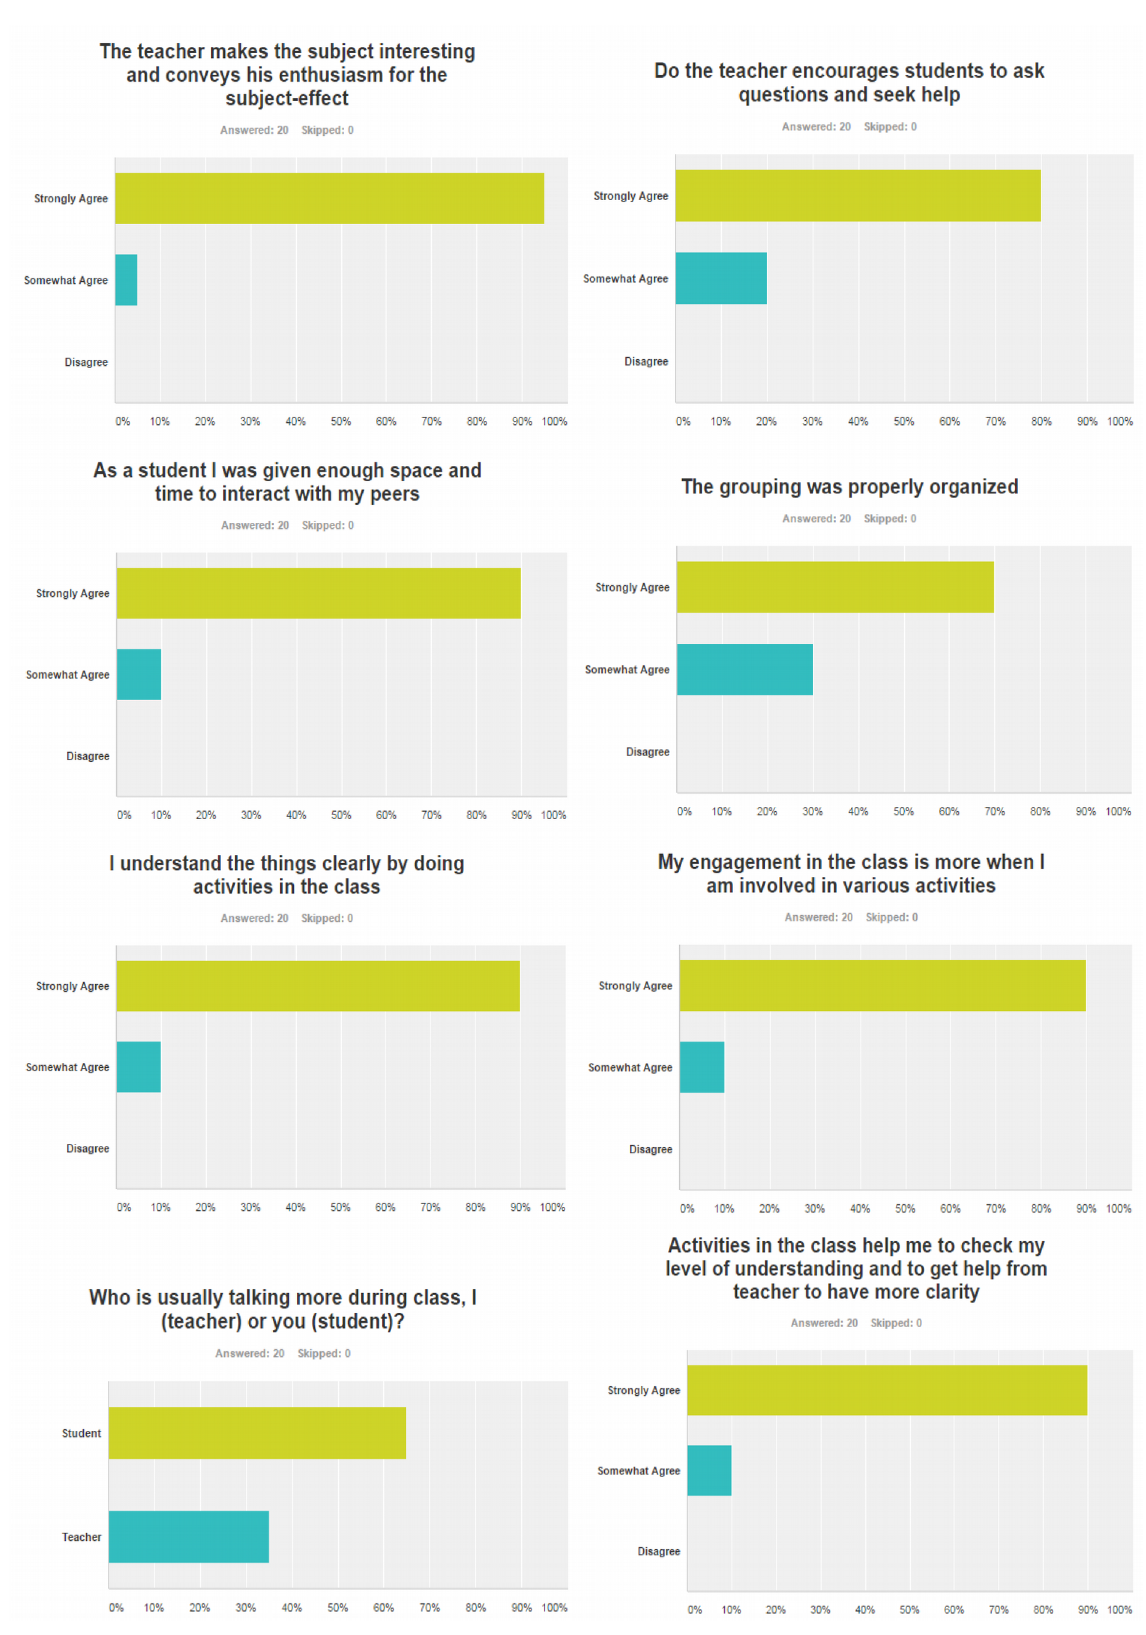
Figure 5. Example of students’ feedback on classroom management and